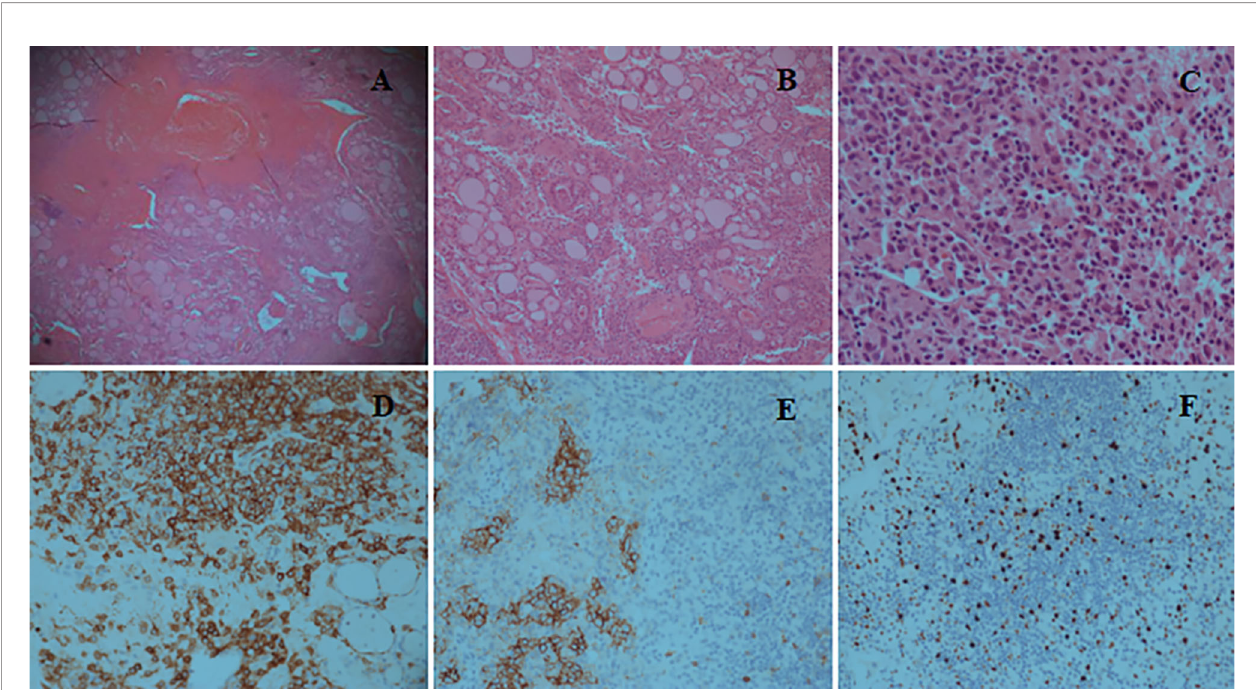
FIGURE 2 | (A) Hematoxylin and Eosin (H&E) staining (×5) reveals tissue necrosis and the in fi ltration composed of Langerhans cells, lymphocytes, and eosinophils. (B) H&E staining (×10) shows sheets and islands of nuclear atypia cells in fi ltration between the thyroid follicles. (C) H&E staining (×40) reveals diffuse proliferation of nuclear atypia cells with typical nuclear grooves and indentation. (D) Immunochemical staining (×20) shows that Langerhans cells are strongly positive for CD1a, whereas thyroid follicular epithelial cells are negative. (E) Immunochemical staining (×20) shows positive reaction for CD56. (F) Immunochemical staining (×20) shows slightly positive reaction for